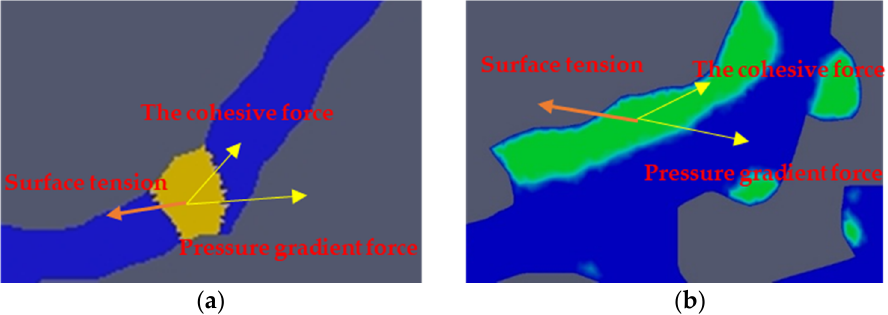
Figure 10. Vector diagram of forces on oil droplets and oil film: ( a ) Force on oil droplets, ( b ) oil film stresses.